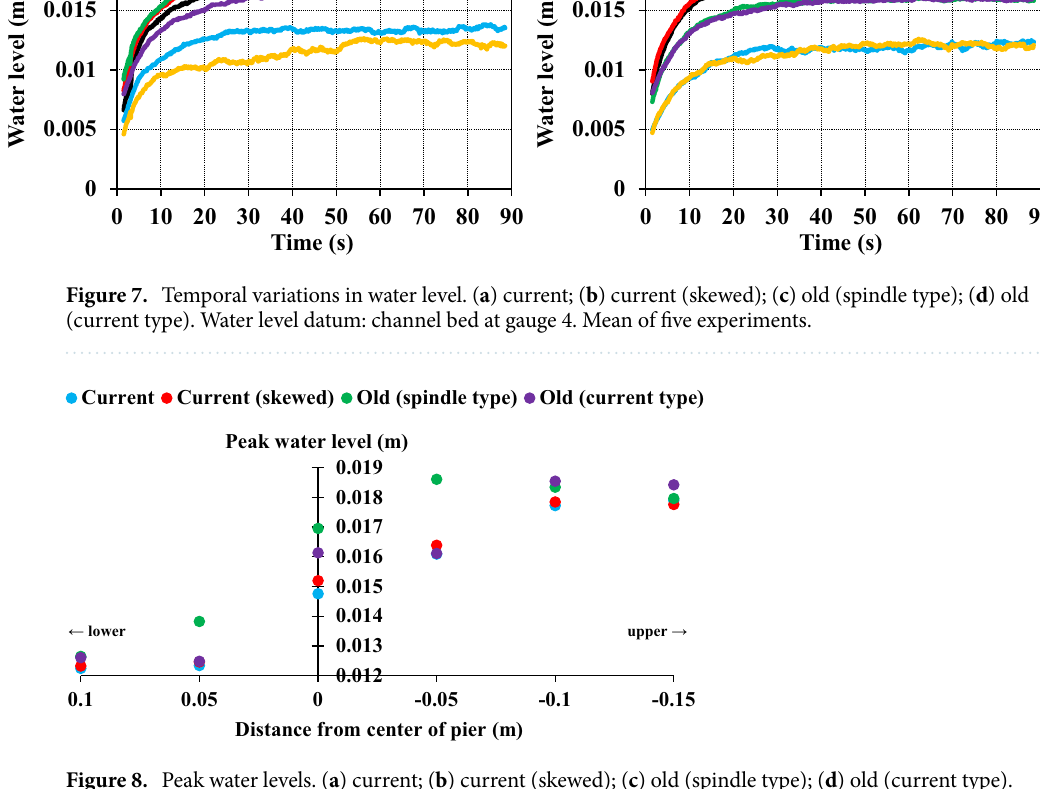
Figure 8. Peak water levels. ( a ) current; ( b ) current (skewed); ( c ) old (spindle type); ( d ) old (current type). Water level datum: channel bed at gauge 4. Mean of five